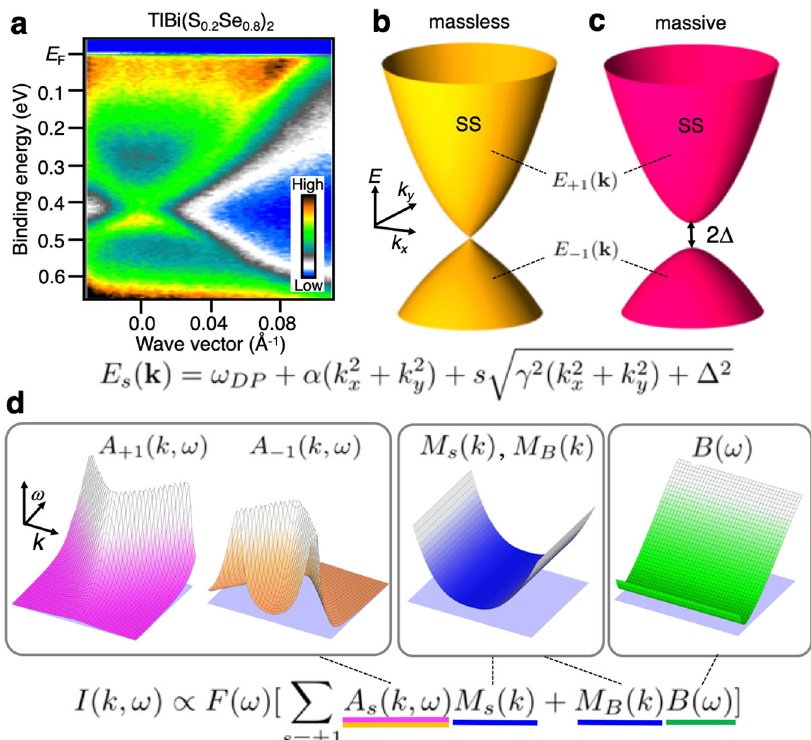
Fig. 2 Semiparametric Bayesian modeling of the gapped Dirac-cone surface state. a Angle-resolved photoemission spectroscopy (ARPES) intensity plot in the vicinity of the Fermi level E F around the Γ point for TlBi(S 0.2 Se 0.8 ) 2 measured at T = 30 K with the Xe-I α line ( h ν = 8.437 eV) 14 . b , c Schematic energy dispersion of gapless and gapped Dirac-cone bands, respectively. The full energy gap is 2 Δ . Analytical form of the bare-band dispersion E s ( k ) used in the model is also shown at the bottom; s , ω DP , α , γ , Δ are branch index [upper ( s = + 1) or lower ( s = − 1) Dirac cone], Dirac-point energy, parabolic dispersion term, Dirac velocity, and Dirac gap, respectively. d Example of simulated ARPES intensity I ( k , ω ) used in the semiparametric Bayesian analysis, which is composed of photoelectron matrix-element term for the surface band M s ( k ), single-particle spectral function A s ( k , ω ), photoelectron matrix-element term for the background M B ( k ) and angle-integrated-type background B ( ω ). F ( ω ) denotes the Fermi – Dirac distribution